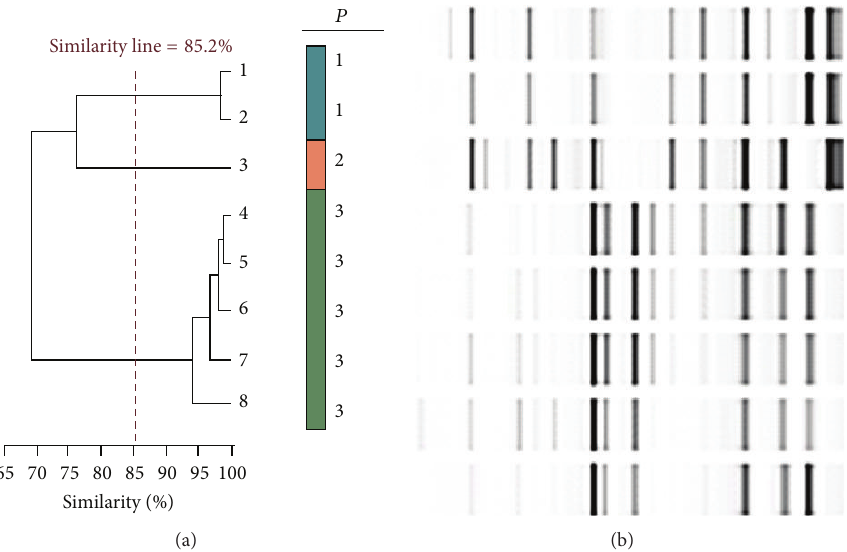
Figure 2: Example of molecular typing of isolates used during the outbreak. It is shown a DiversiLab system-generated dendrogram, showing the first five case outbreak A. baumannii isolates, compared with two other A. baumannii clones, detected before in the Hospital. The dendrogram shows strain clustering. The horizontal bar at the bottom left of the dendrogram indicates the percent similarity coefficient within the strains. Spacing between grid lines indicates increments of 5% similarity based on the proximity matrix results.